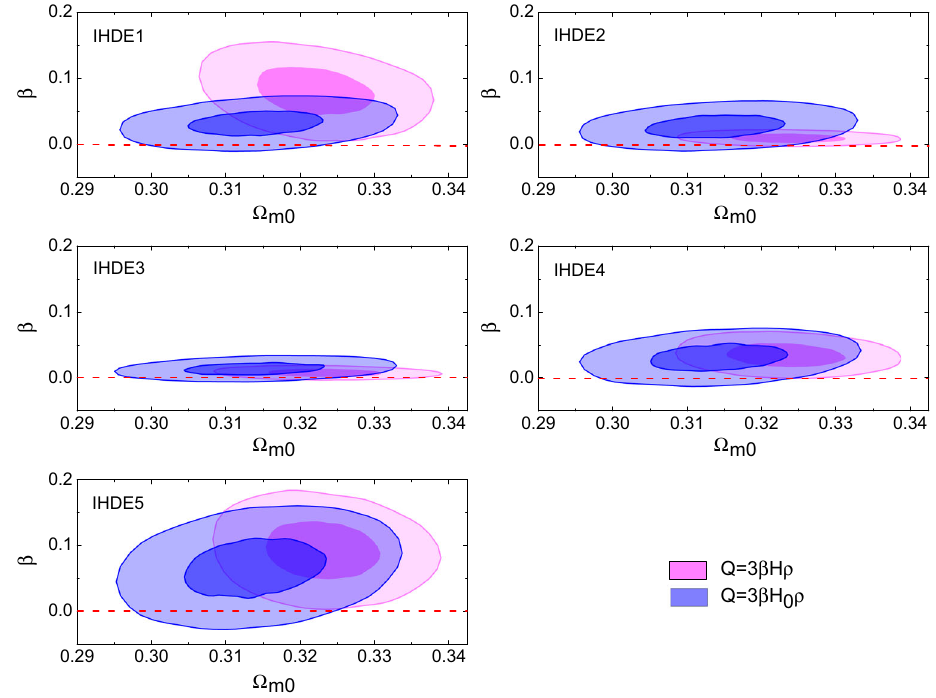
Fig. 3 The SN + CMB + BAO + H 0 constraints on the HDE model and the IHDE models. The 68.3 and 95.4% confidence level contours are shown in the (cid:7) m0 – β plane. The red dashed line denotes the case of β =